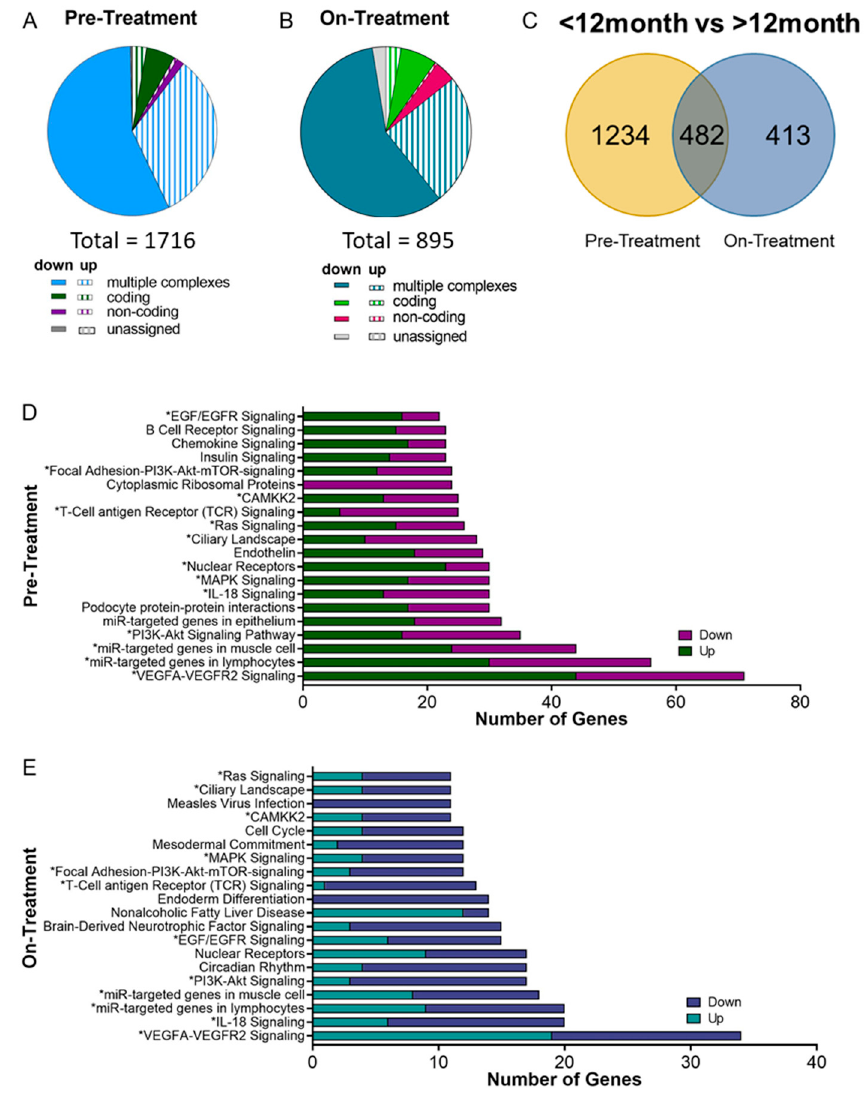
Figure 4. CTC differential gene expression and pathway analysis based on patient survival. ( A , B ) Differential gene expression based on patient survival duration for ( A ) pre-treatment and ( B ) on-treatment CTC samples. ( C ) Venn diagram comparison of differentially expressed genes based on survival at time points, pre-treatment only, on-treatment only, or both pre- and on-treatment. ( D , E ) Top 20 deregulated pathways based on number of differentially expressed genes in pathway between patients with survival <12 months and survival >12 months for ( D ) pre-treatment and ( E ) on-treatment CTC samples. * indicates statistically significant pathway deregulation between poor and improved treatment ( p < 0.05).